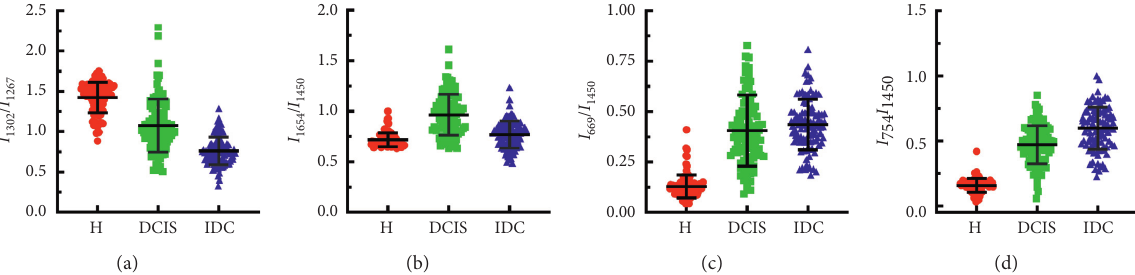
Figure 3: Comparisons among relative intensity ratios of the selected Raman bands with the corresponding tentative biochemical as- signments of the tissue samples. All data are represented as mean ± standard deviation values. (a) Ratio for saturated lipid. (b) Ratio for unsaturated lipid. (c) Ratio for nucleic acid to lipid. (d) Ratio for protein to